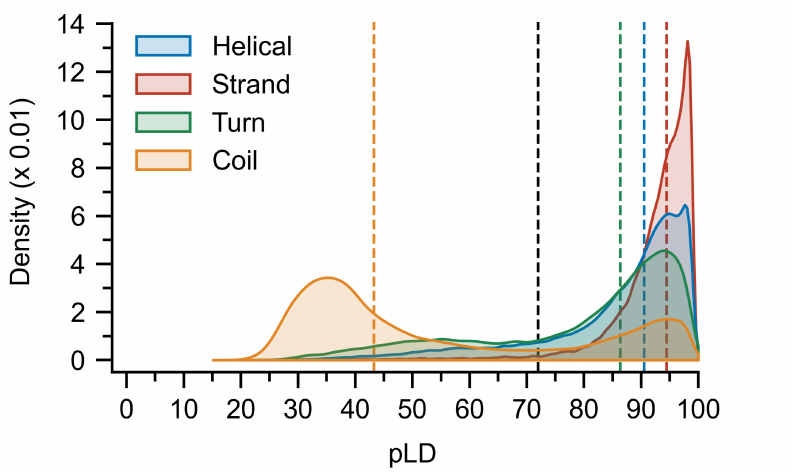
Figure 4. Distribution of pLDDT values per residue calculated for each secondary structure class. Bin- widths were set at 0.5 and bootstrapping, that is, sampling with replacement, was used to compute the distributions and mean values (colored vertical dashed lines; black dashed line represents pLD 72 ) with 10,000 samples of size 500. A bimodal distribution is evident for the coil structures, and while strand, helical, and turn regions are on average assigned to high pLDDT values, residues belonging to each can sample much lower values. pLDDT is abbreviated pLD for plotting